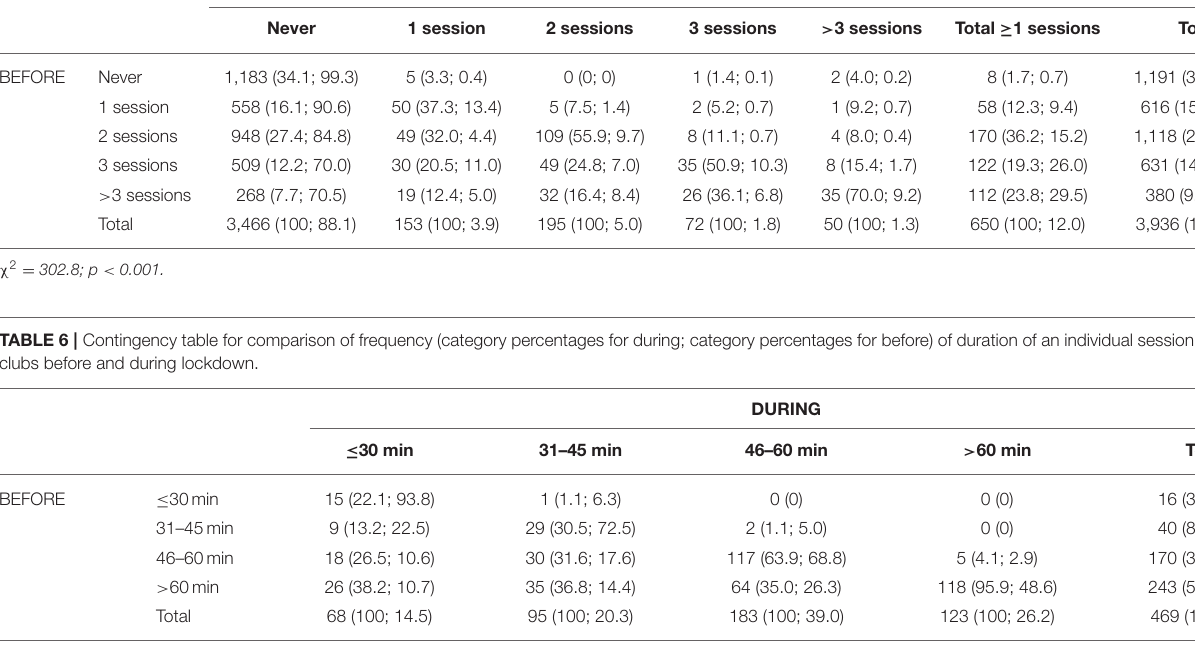
TABLE 5 | Contingency table for comparison of frequency (category percentages for during; category percentages for before) of participation in sports clubs before and during lockdown. DURING Never 1 session 2 sessions